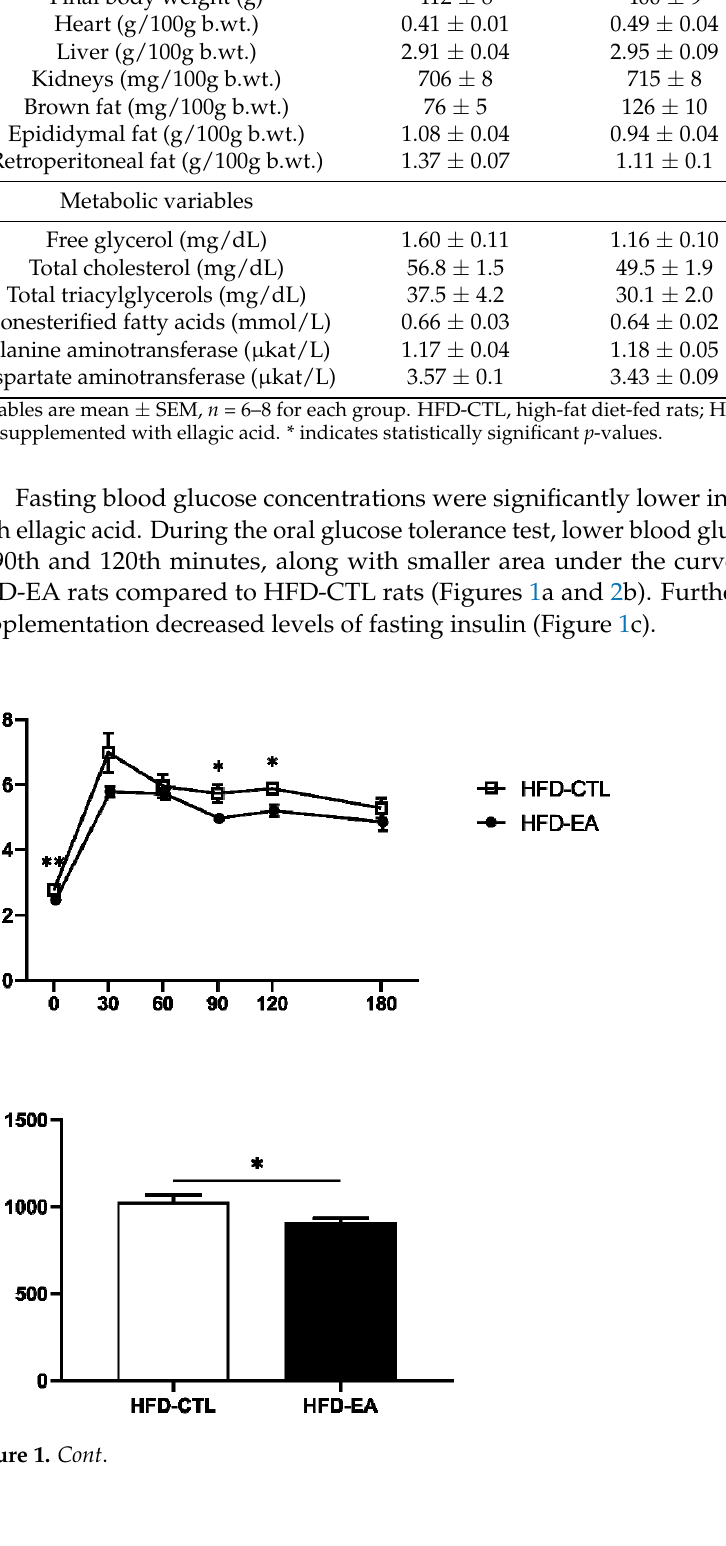
Figure 1. Effect of ellagic acid supplementation on blood glucose levels during ( a ) oral glucose tolerance test, ( b ) area under the curve (AUC), and ( c ) insulin levels. Values are mean ± SEM, n = 8/group. The significance levels for comparison between control (HFD-CTL; high-fat diet-fed rats) and experimental (HFD-EA; high-fat diet-fed rats supplemented with ellagic acid) groups are indicated as follows: * p < 0.05, ** p < 0.01.